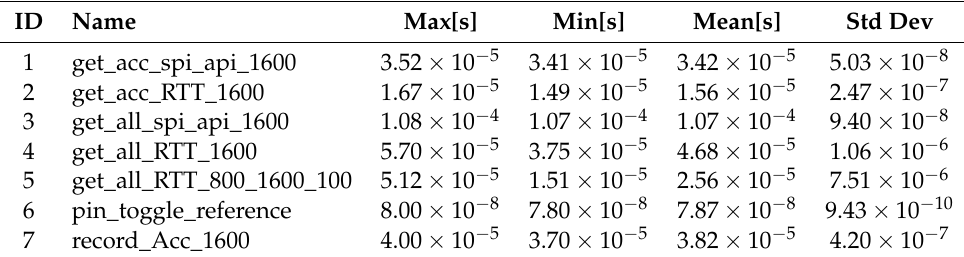
Table 4. Measured timing behavior with optimization